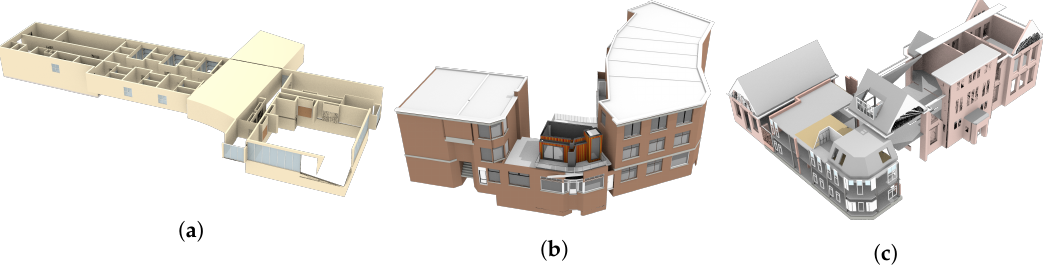
Figure 5. Test IFC files from the City of The Hague after processing with initial methodology. ( a ) CUVO Ockenburghstraat KOW; ( b ) Rabarberstraat 144; ( c ) Witte de Withstraat.